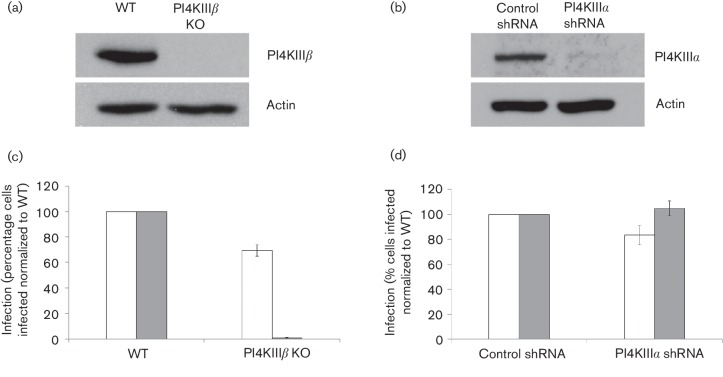
Western blot for (a) PI4KIIIβ in WT and PI4KIIIβ knockout (PI4KIIIβ KO) Huh7-Lunet T7 cells (8 µg protein loaded per lane) and (b) PI4KIIIα in Huh7-Lunet T7 cells expressing a control or PI4KIIIα shRNA (18 µg protein loaded per lane). Actin was included as a loading control. (c) WT (control) and PI4KIIIβ KO Huh7-Lunet T7 cells and (d) Huh7-Lunet T7 cells expressing a control shRNA (control) or PI4KIIIα shRNA were grown on glass coverslips infected with FMDV (white bars) and BEV-1 (grey bars) (m.o.i.=0.6) for 4 h, fixed and processed for confocal microscopy. Infected cells were identified by labelling for FMDV 3A or BEV-1, respectively. Infection was scored and normalized to that seen in control cells for each virus. The mean±sd for triplicate coverslips are shown (n>650 per coverslip).